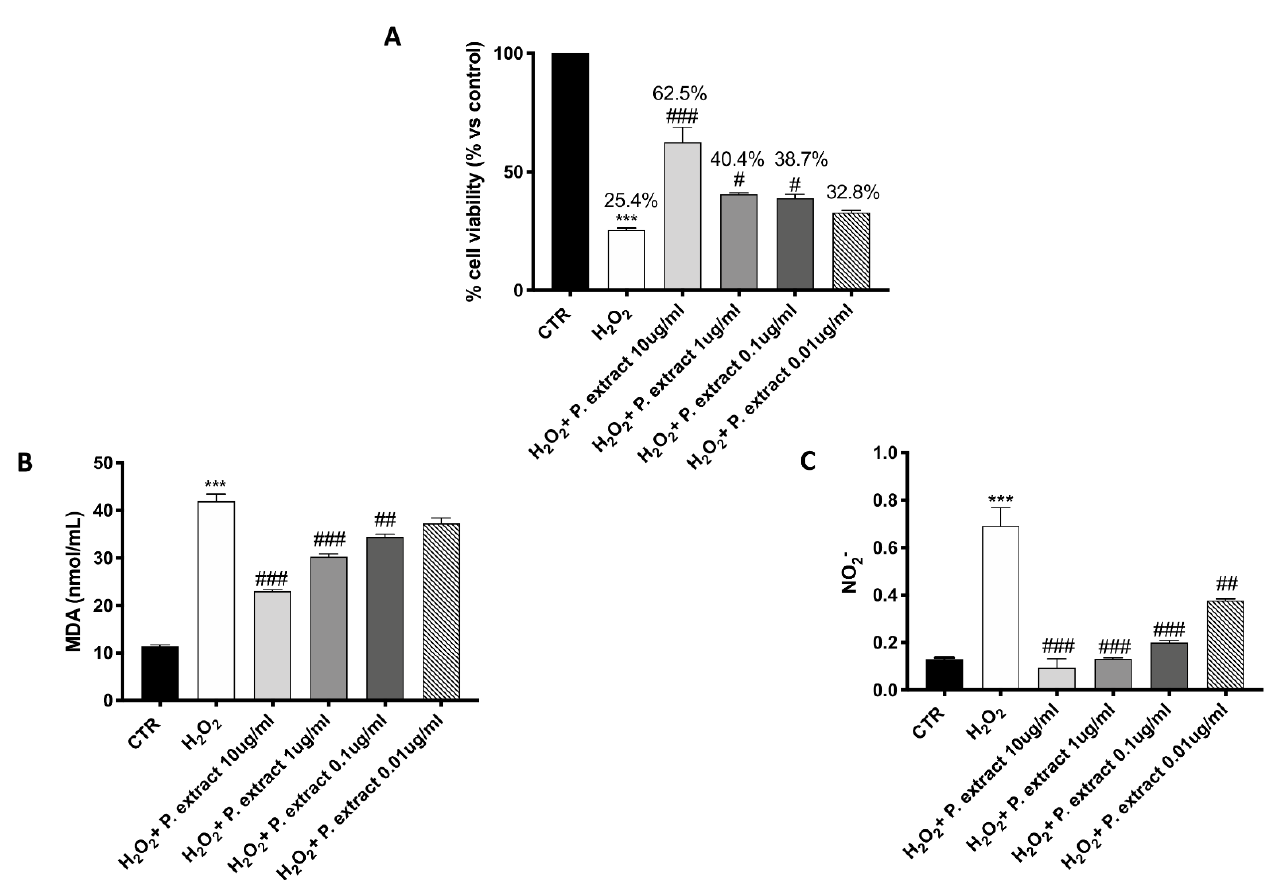
Figure 1. Antioxidant effect of Propionibacterium extract in L-929 culture. Pre-treatment with Propionibacterium extract, in a concentration-dependent manner, considerably prevented H 2 O 2 cytotoxicity ( A ) and reduced MDA ( B ) and NO 2− ( C ) levels in the cell lysate, following H 2 O 2 stimulation. Data are representative of at least three independent experiments. Values are provided as means ± SEM. One-way ANOVA test. *** p < 0.001 vs. CTR; # p < 0.05 vs. H 2 O 2 ; ## p < 0.01 vs. H 2 O 2 ; ### p < 0.001 vs. H 2 O 2 .